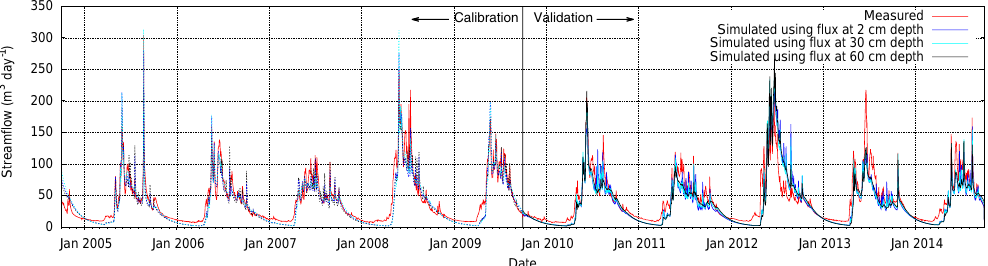
Figure 9. Measured and simulated daily streamflow for the outlet of the Dischmabach. Dashed lines denote the calibration period; solid lines denote the validation period. Major ticks on the x axis are drawn at 1 January of each year; minor ticks are drawn at every other first of the